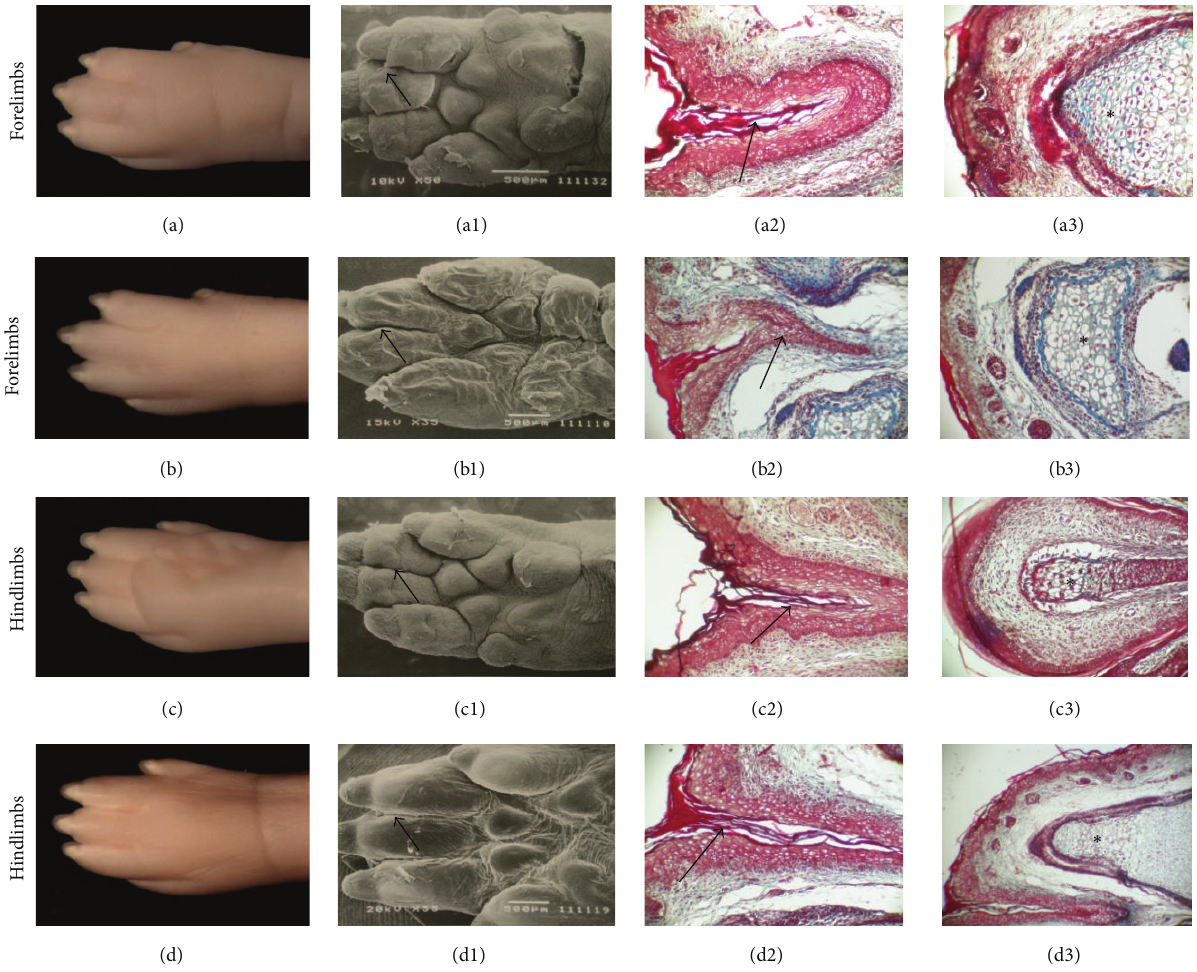
Figure 5: The morphohistology of the limbs of newborn pups obtained from control rats ((a), (c)) and diabetic rats ((b), (d)). Note that the interdigitating (arrows) and ossification ( ∗ ) processes were similar in both study